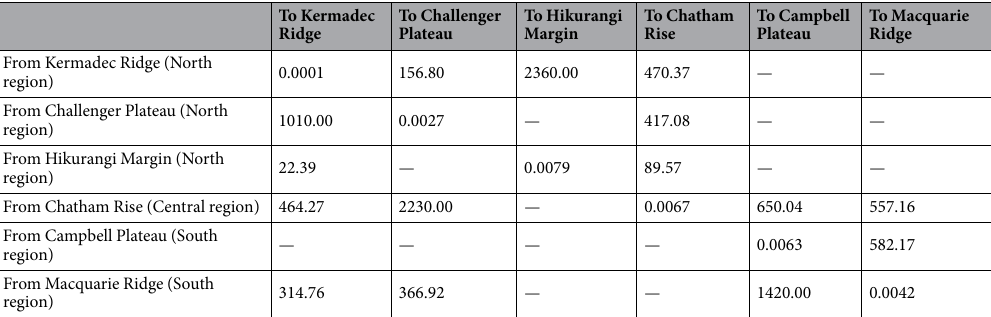
for only Poecillastra laminaris and N . persicum , (2) haplotype accumulation analyses showed that all four species did not have enough specimens to recover all expected haplotypic diversity, and (3) in several cases individual population sample sizes were small (arbitrarily set minimum of 4 individuals for all analyses). Nonetheless, a fuller understanding of the population genetics of many deep-sea taxa must be pursued with less than perfect sample sets because of limited sampling opportunities, and the urgent management need to protect biodiversity, in particular VMEs. Hence, studies such as the present one, and that of Boschen et al . 15 , attempt to minimise the biases of small sample sizes by using conservative analytical approaches and qualitative interpretations of genetic structure and patterns of connectivity.